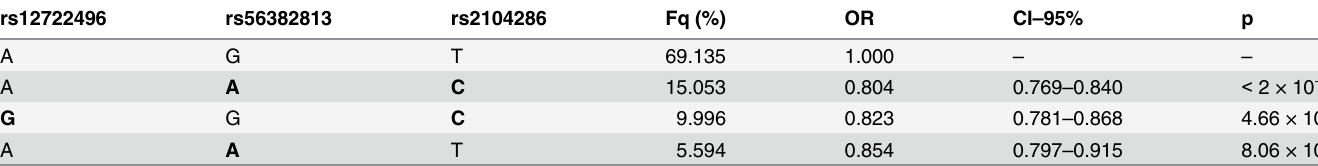
Table 4. Haplotype analysis of MS association using the index SNPs for the one and two SNP models selected. Minor alleles are indicated by bold font. Fq = haplotype